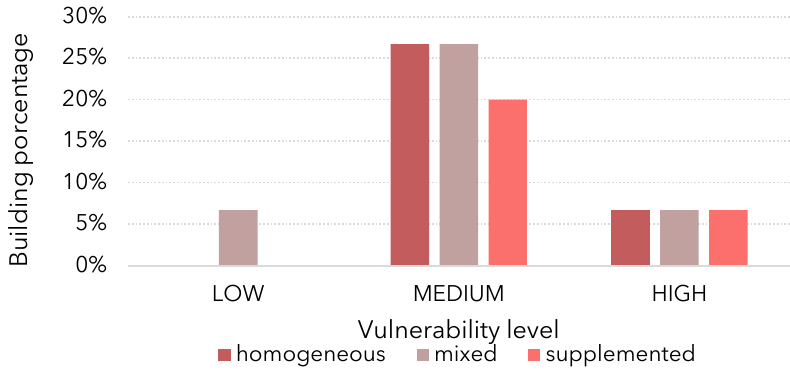
Figure 9. Comparison of the vulnerability index between adobe construction systems.